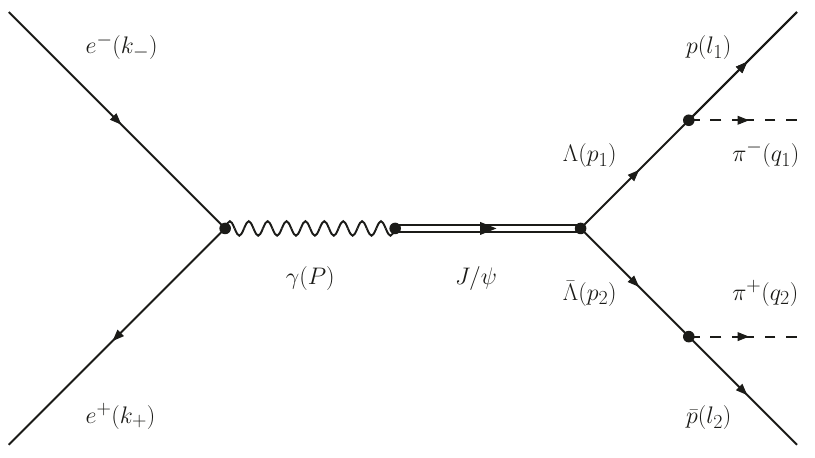
Figure 1 . Diagram of the e + e (cid:0)